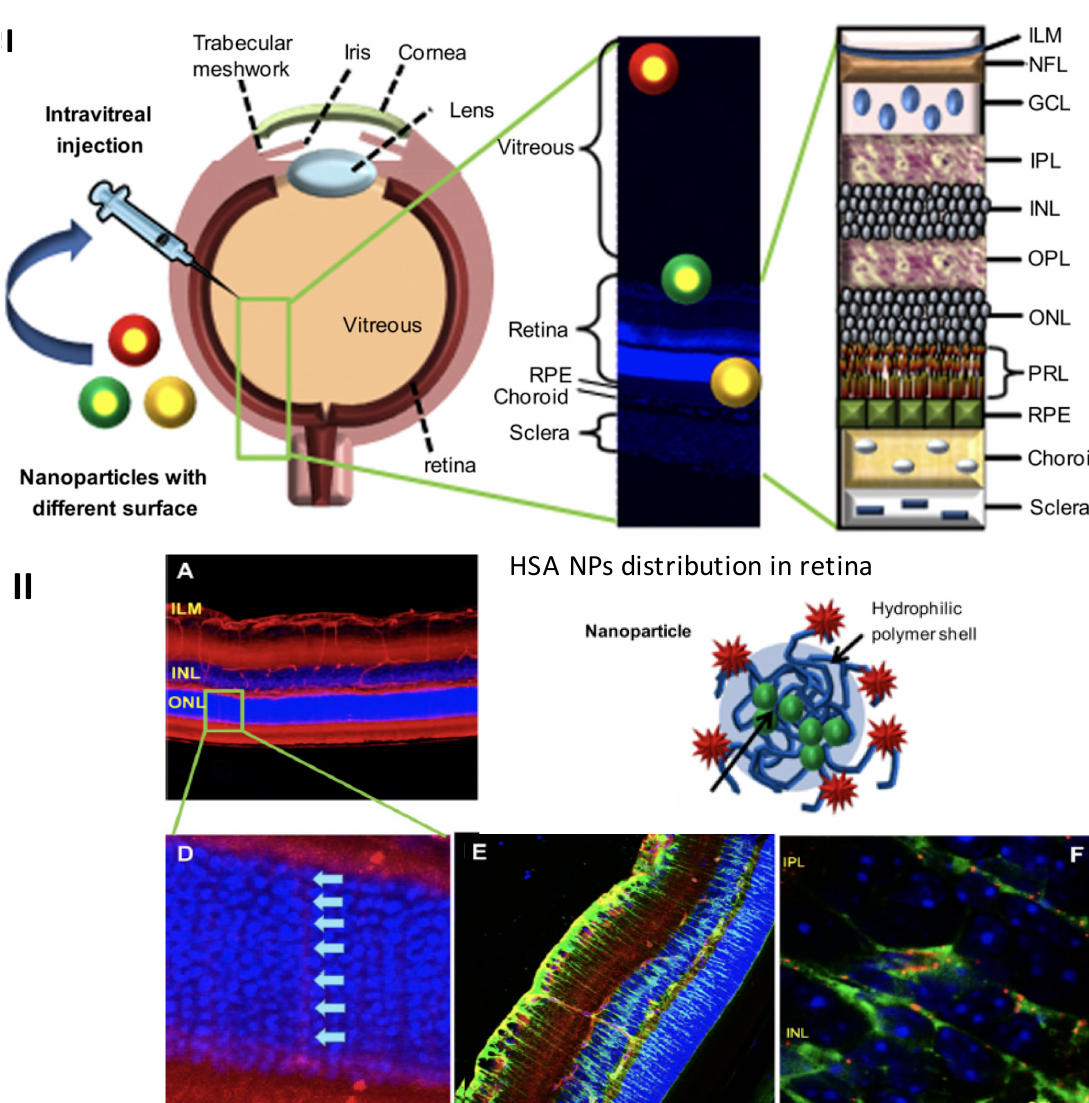
Figure 3. ( I ) Distribution of NPs with various surface properties in the different region of vitreous and retina via intravitreal injection. ( II ) Distribution of HSA NPs (red channel) in the retina via intravitreal injection. ( A , D ) Penetration of HSS NPs into the retina at 6 h post-injection, ( E ) scan of the whole retina, and ( F ) colocalization with Müller cells (green channel). ILM: inner limiting membrane, NFL: nerve fiber layer, GCL: ganglion cell layer, IPL: inner plexiform layer, INL: inner nuclear layer, OPL: outer plexiform layer, ONL: outer nuclear layer, PRL: photoreceptor layer, RPE: retinal pigment epithelium. Image adapted from Koo et al. (2012) and reprinted with permission from Biomaterials (Koo et al. 2012) [42].